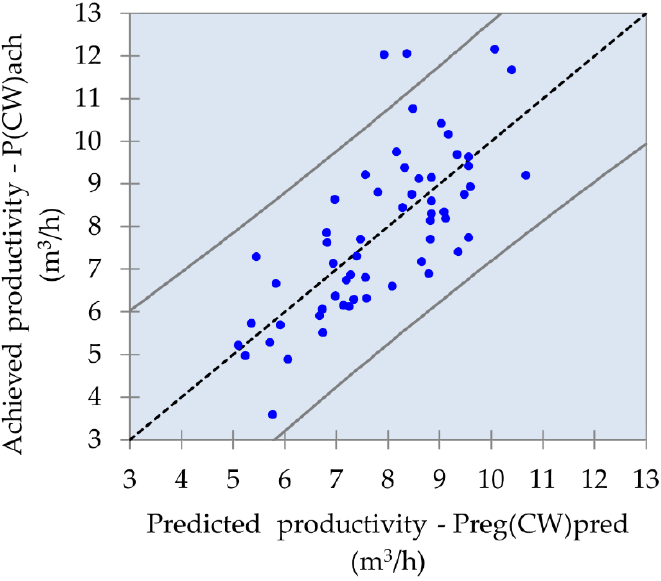
Figure 1. Agreement of achieved and predicted productivity–regression